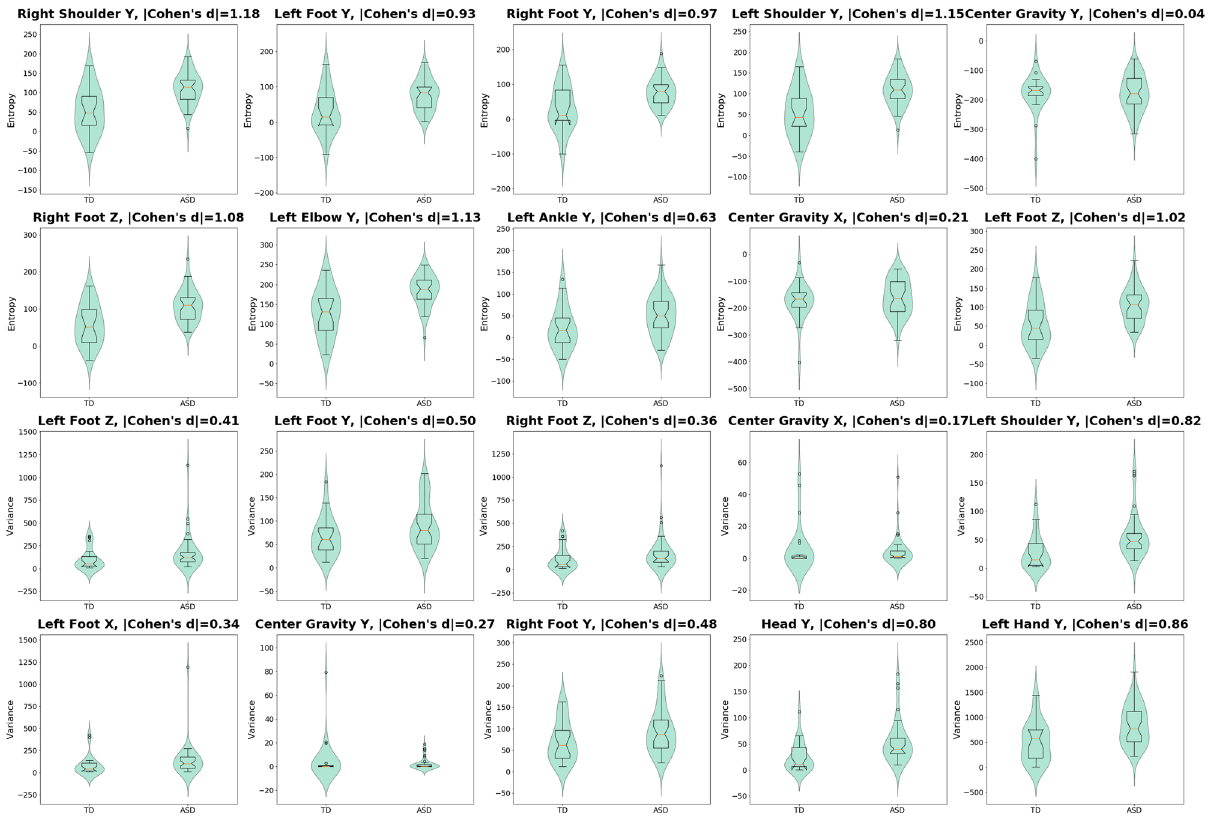
Figure 4. Distributions of top-ranked feature values for ASD vs. TD participants, and Cohen’s d effect sizes of their